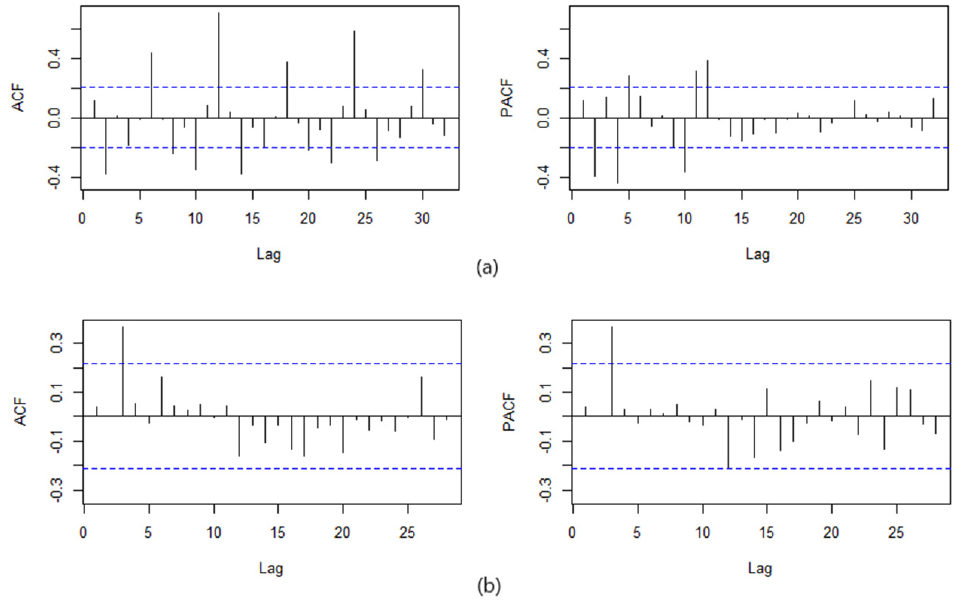
Figure 3. The ACF and PACF plots of monthly incidence of AIDS in Henan province from 2012 − 2019: ( a ) plots before seasonal difference and ( b ) plots of one-order seasonal